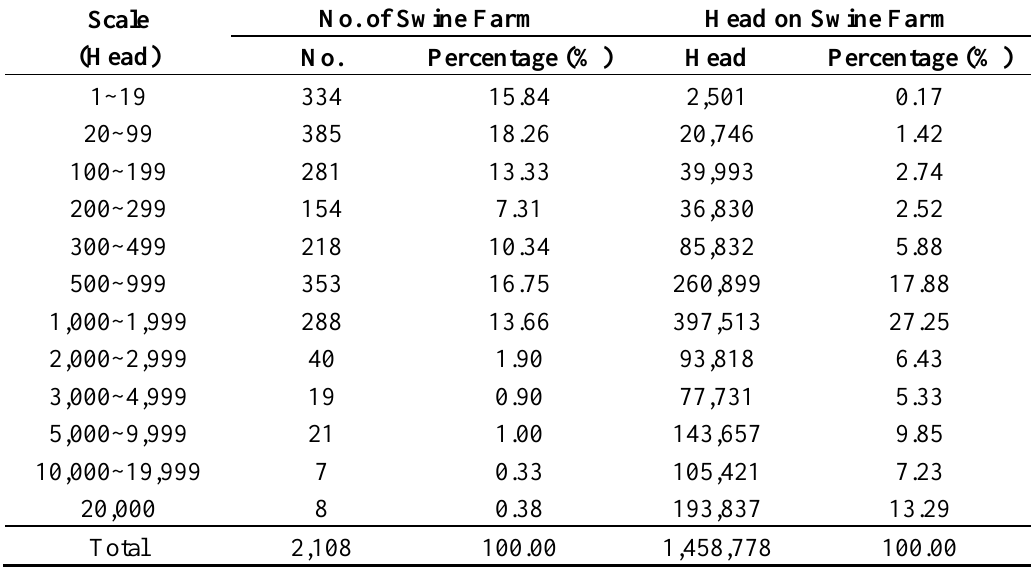
Table 3. Statistics on swine raised in Pingtung county